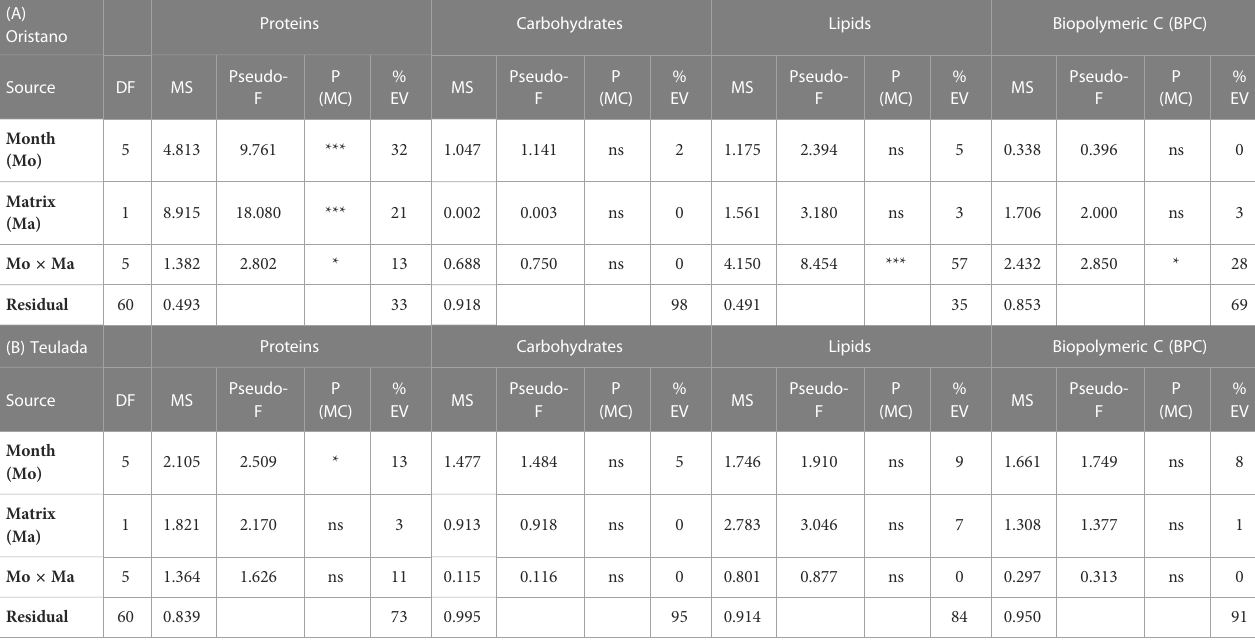
TABLE 1 Results of univariate PERMANOVA testing for the effects of Months (Mo) and Matrices (Ma) and their interaction on protein, carbohydrate, lipid and BPC contents in sediments and feces from the two sites of Oristano (A) and Teulada (B). (A) Oristano